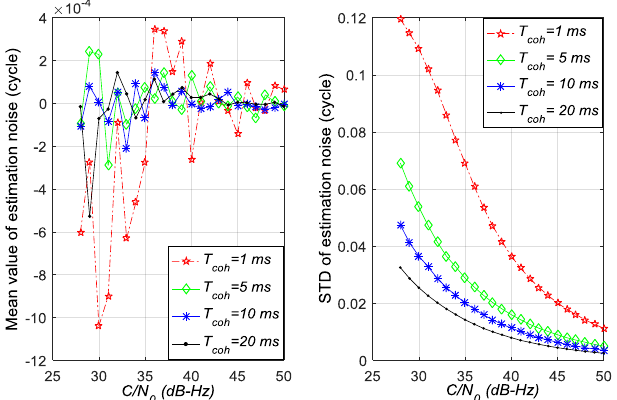
Figure 5. Mean values and standard deviations of estimation noise for ATAN discriminator in different C / N 0 and T coh .